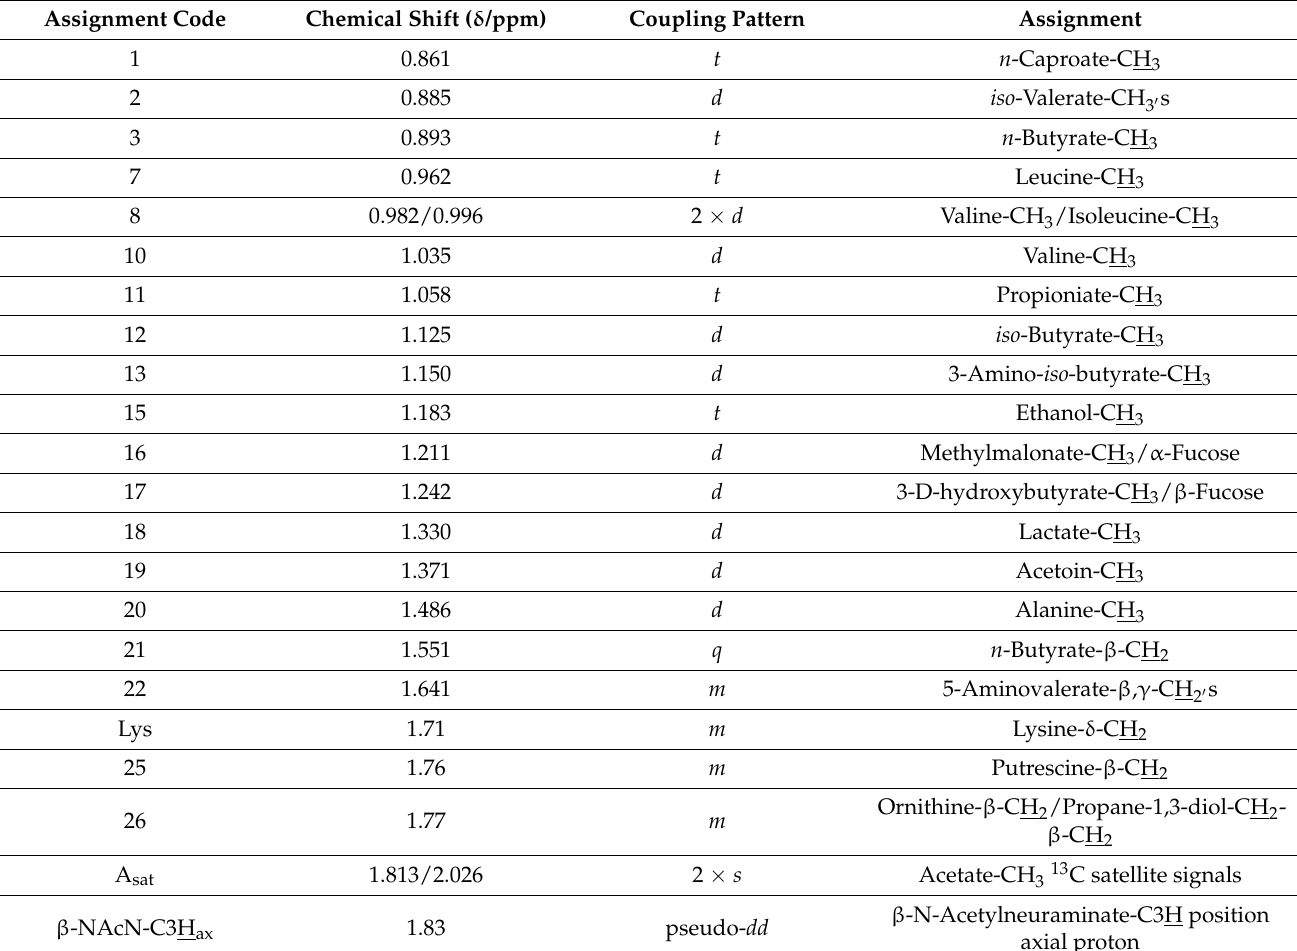
Table 1. Assignments of resonances in the 600 MHz 1 H NMR spectra of WMS supernatant samples for the expanded δ = 0.80–2.45 and 5.10–8.60 ppm regions only. Chemical shift (ö) values and resonance coupling patterns are also provided. * Indicates tentative assignment. Resonances and their assignments within the 2.45–5.10 ppm regions of spectra (signals 47–95) are omitted for the purpose of clarity, but these may be viewed in Part I of this series of reports